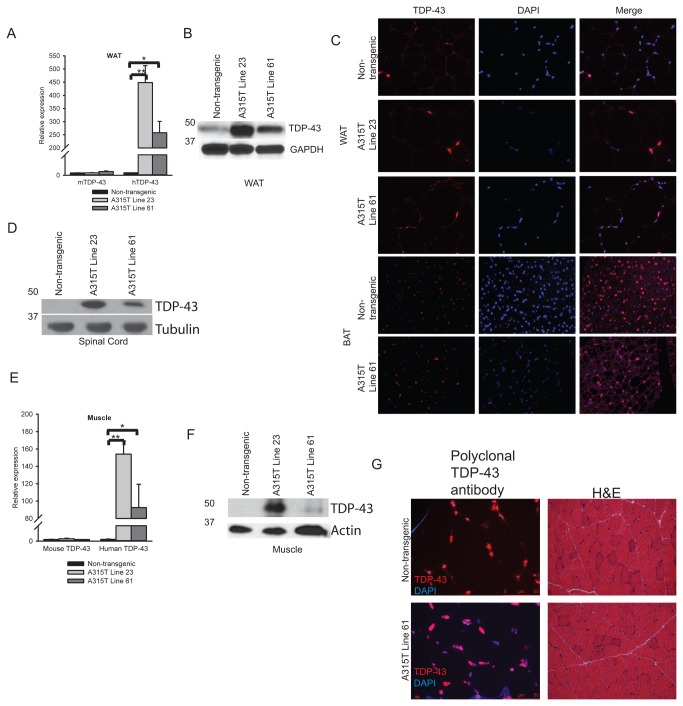
White adipose tissue and muscle in A315T line 23 and line 61 have increased TDP-43 levels.(A) Quantification of TDP-43 endogenous and transgene mRNA levels in WAT (6 weeks, N=4). Data are fold gene expression normalized with cyclophilin and expressed as mean ± S.E.M. *P<0.05, **P<0.001. (B) TDP-43 protein levels in WAT from 6 week old mice probed with polyclonal antibody that recognizes both human and mouse TDP-43. (C) TDP-43 immuno-reactivity in WAT and BAT of non-transgenic (16 weeks). A315T line 23 (6 weeks) and A315T line 61 mice (16 weeks). Magnification=400X. (D) TDP-43 protein levels in spinal cord from non-transgenic, A315T line 23 and A315T line 61(12 week old) mice using monoclonal antibody which recognizes human TDP-43 only. (E) Quantification of TDP-43 endogenous and transgene mRNA levels in skeletal muscle (6 weeks, N=4). Data are fold gene expression normalized with cyclophilin and expressed as mean ± S.E.M. *P<0.05, **P<0.005. (F) TDP-43 protein levels in skeletal muscle of non-transgenic, A315T line 23, A315T line 61 mice (12 weeks of age) using polyclonal antibody. (G) TDP-43 immunoflorescence and H&E stained sections of skeletal muscle of non-transgenic and A315T line 61 (16 weeks of age). Magnification: 400X for immunoflorescence,200X for H&E. 5 µg of total protein loaded per lane for spinal cord and muscle western blot. 10 µg of total protein loaded per lane for WAT western blot. 1 µg of total protein loaded per lane for muscle western blot. Tubulin, actin or GAPDH were used as loading controls. Representative western blots are shown, each sample was run ≥ 2 times with N≥ 2 mice in each group analyzed.